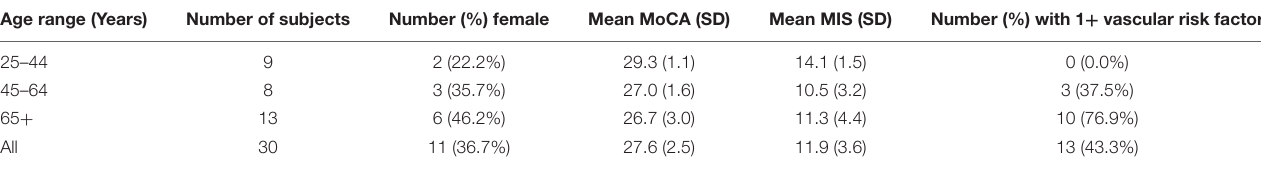
TABLE 1 | Clinical and demographic characteristics of the study population. Age range